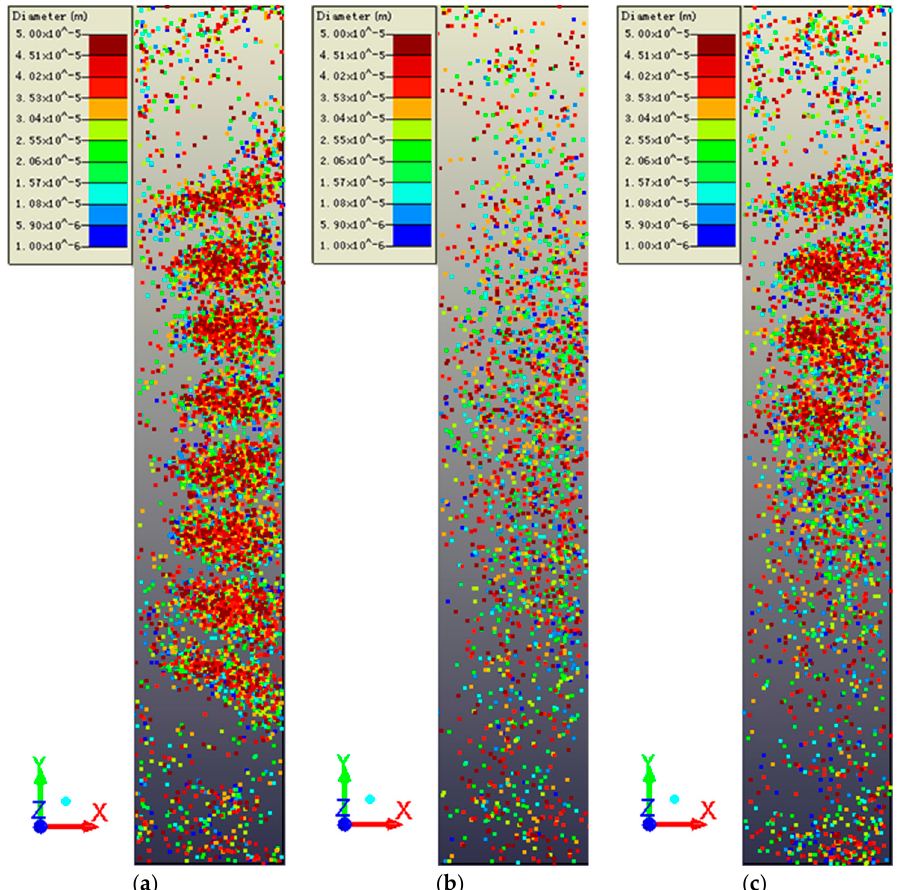
Figure 11. Distributions of the inclusions at the molten steel surface in MHDB. ( a ) UILO mode; ( b ) LIUO mode; ( c ) X mode.